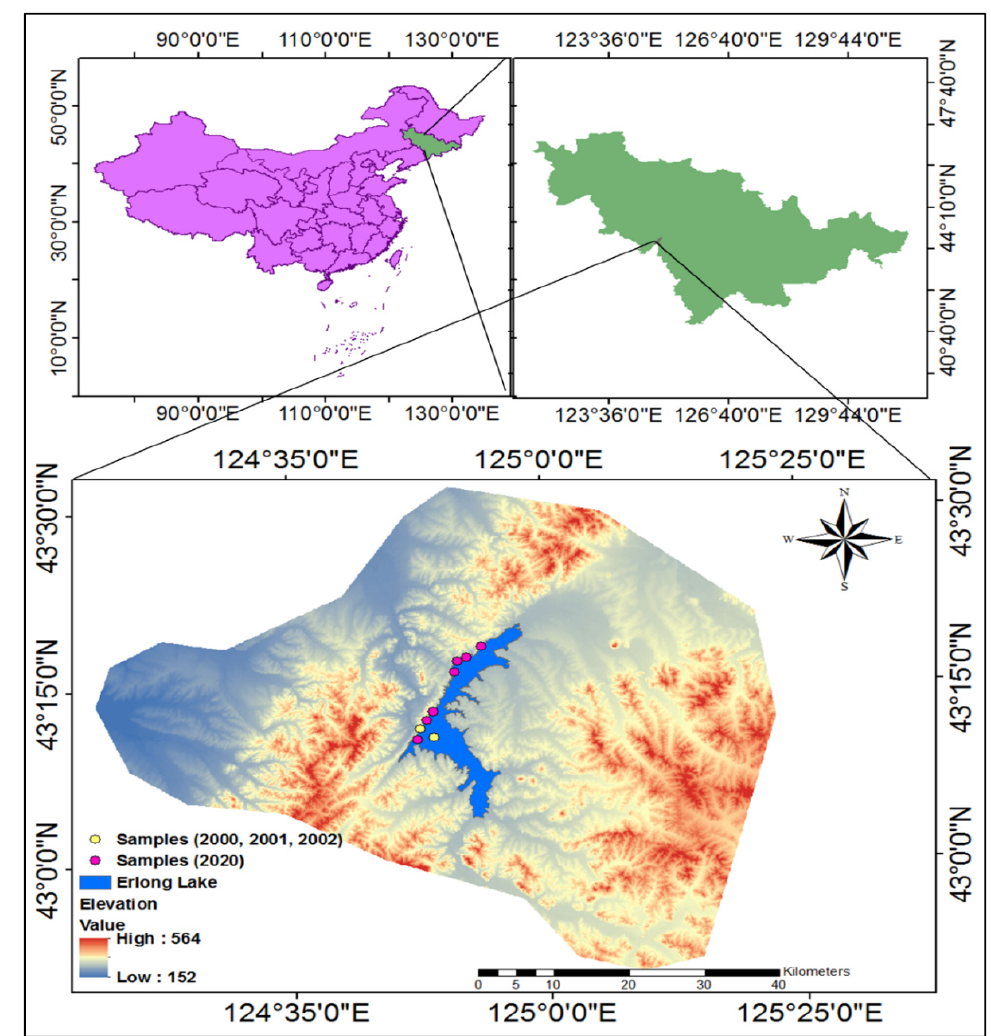
Figure 1. Study area map and locations of the water samples.